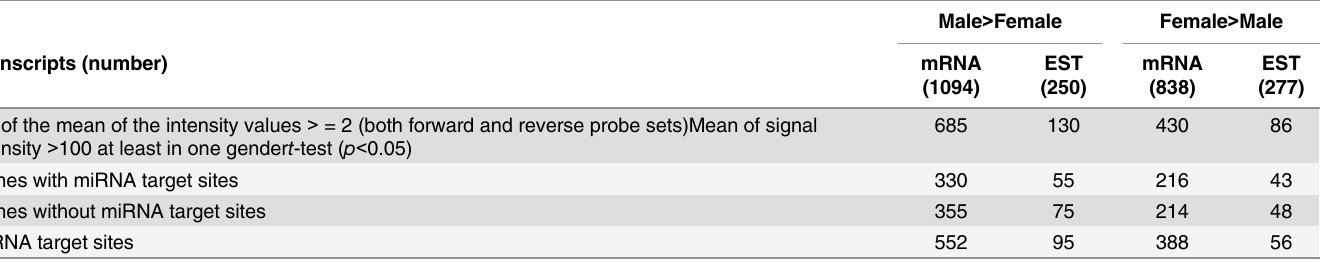
Male > Female Female > Male EST mRNA EST (1094) (250) (838) (277) 685 130 430 86